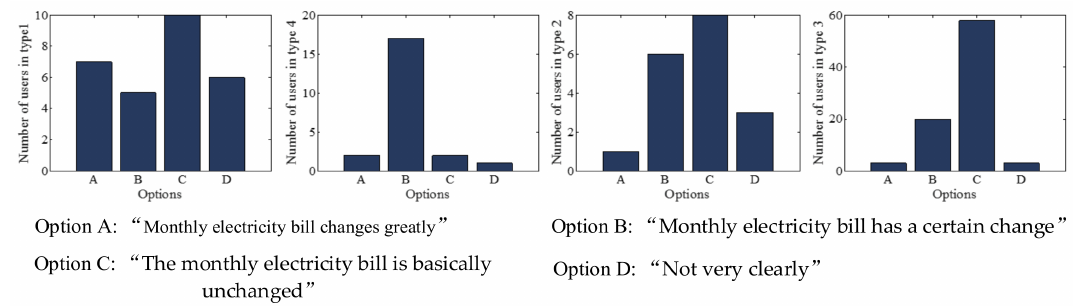
Figure 6. Distributions of answers to “Variation degree of monthly electricity bills” for users in the four